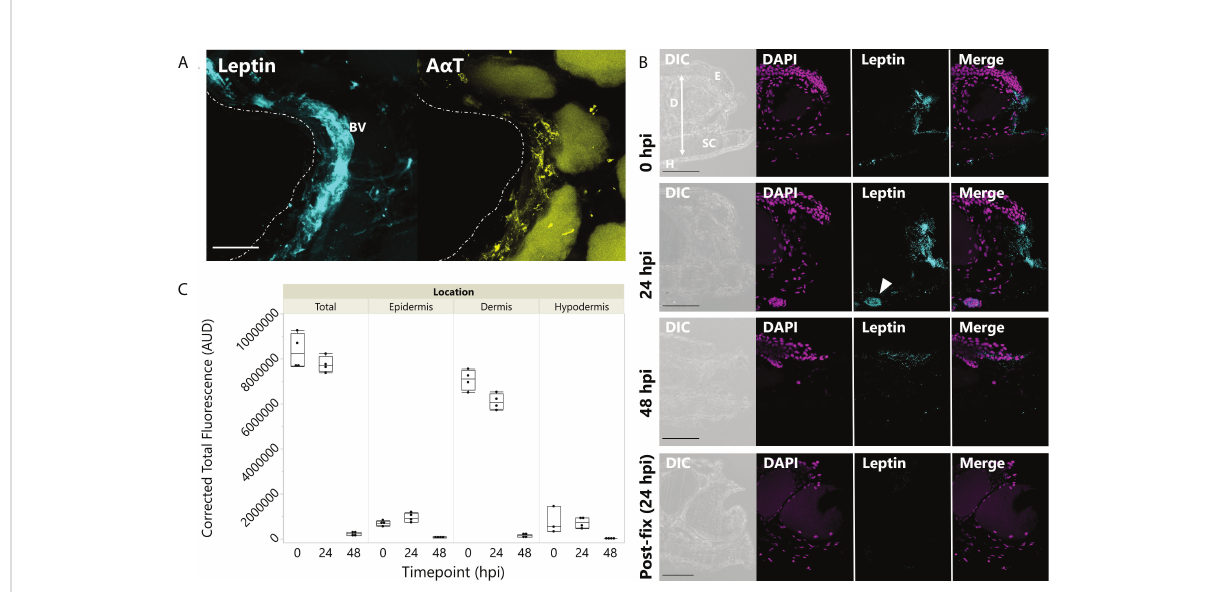
FIGURE 3 Leptin protein is rapidly localized to injured skin. (A) Whole mount of leptin protein (aqua) and acetylated a -tubulin (A a T, yellow) at the time of injury in juvenile Xenopus laevis dorsal skin. Dotted line indicates injury at the center of the donut-shaped explant. Leptin is highly expressed in blood vessels and nerve tissue (indicated by A a T) associated with the injury site. Granular glands are auto fl uorescent after bleaching and clearing at 488 nm (as seen in the A a T panel). Scale bar, 100 µm. (B) Leptin protein expression in 16-µm cross sections of juvenile X. laevis dorsal skin after injury. Leptin expression (aqua) is concentrated in the injured tissue at 0 and 24 hpi and nearly depleted by 48 hpi in vitro except for some localized in the epidermis (DAPI, magenta). Epidermis (E), dermis (D), stratum corneum of the dermis (SC), and thin hypodermis (H). Arrow in 24 h panel indicates blood vessel. Scale bars, 100 µm. (C) Leptin is most highly expressed in the central dermis after injury, but expression within 300 µm of the injury site in all skin layers is depleted by 48 hpi in culture (standard least squares ANOVA, time point, p <